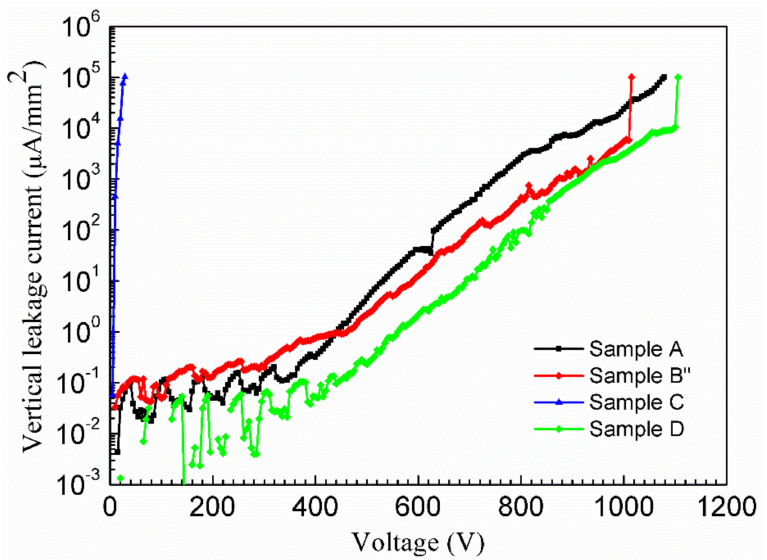
Figure 5. Vertical leakage current performance of the four samples at room